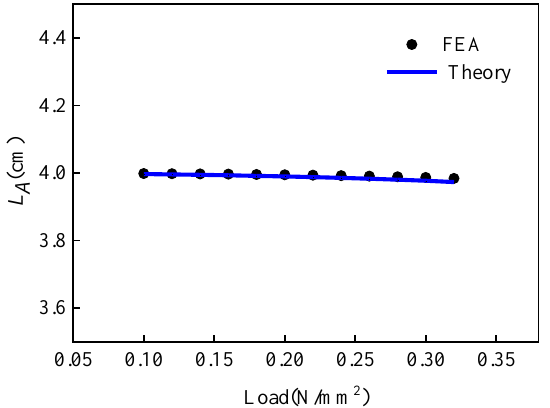
Figure 6. Curves of beam end deformation and load under small deformation (The length of the chiral ligament beam is 40 mm).